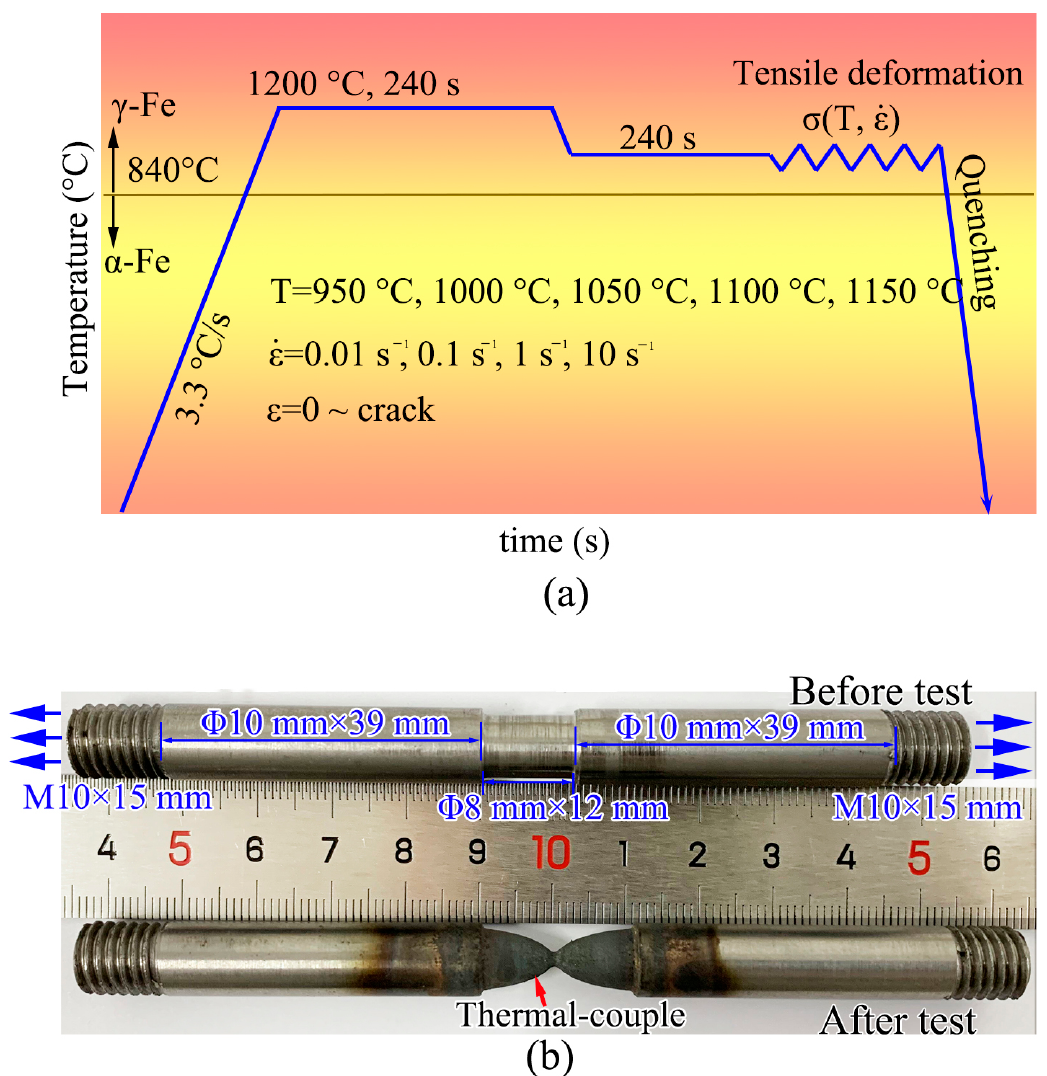
Figure 2. Experimental procedure. ( a ) thermal-mechanical process, ( b ) specimen photos before and after deformation. Table 1. Experimental parameters. Test No.